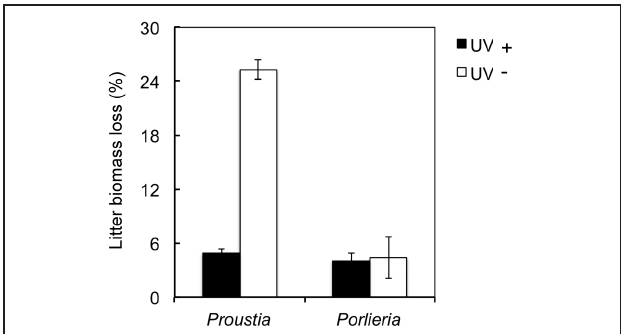
FIGURE 1 | Effects of UV exposure on litter biomass after a 5-months experiment in semiarid Chile. Data shown for deciduous Proustia and evergreen Porlieria . UV − represents a reduction of 96–98% of natural UV levels; UV + is the control treatment without UV filters. Data are means ± 1 SE (thin